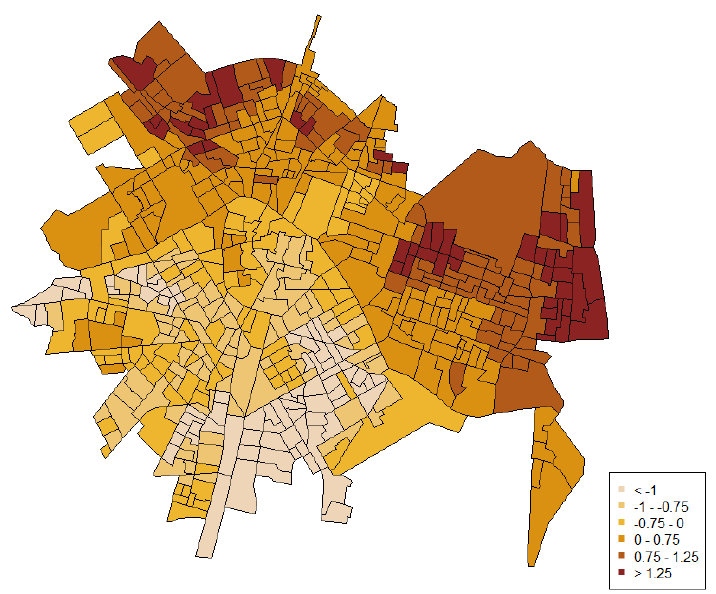
Figure 3. Posterior mean values for the spatial component (census block group) of the estimated prevalence of drug-related police interventions.